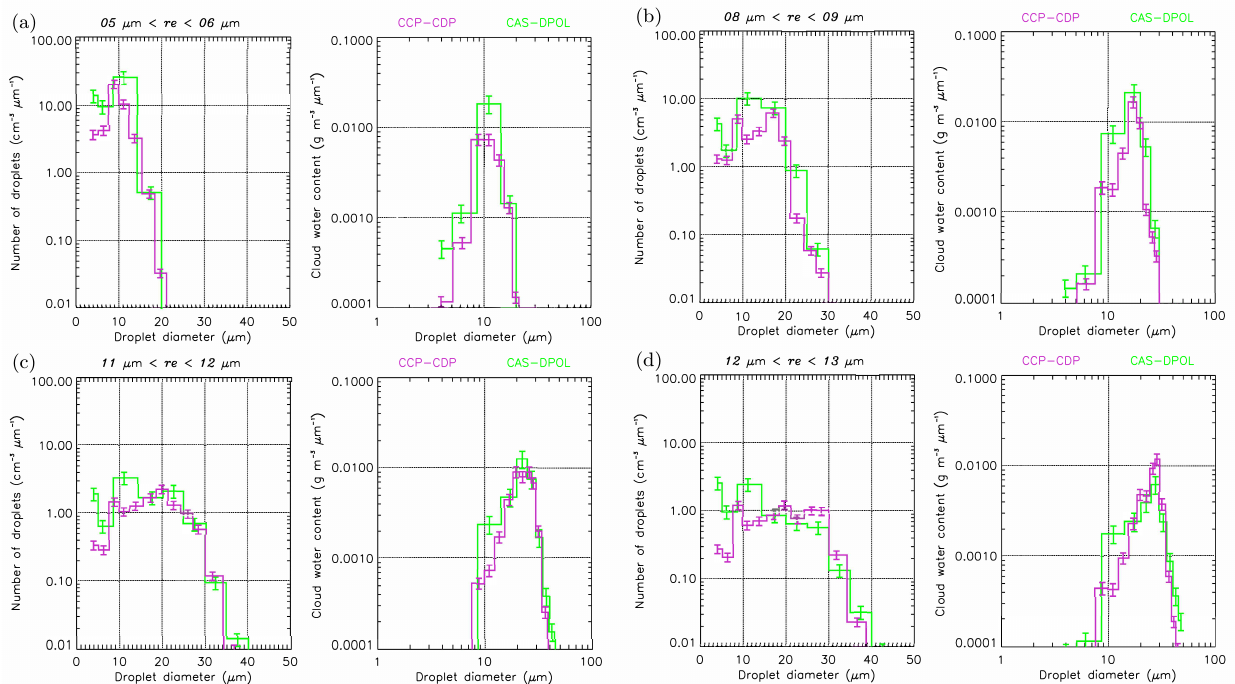
Figure 6. Mean cloud droplet concentration (solid lines) and cloud water content as a function of droplet diameter in the left and right panels, respectively, for (a) 5 µm <r e < 6µm, (b) 8µm <r e < 9µm, (c) 11µm <r e < 12µm, and (d) 12µm <r e < 13µm. The probes are identified by colors as shown at the top of the panels. The error bars indicate the uncertainty range of mean cloud droplet concentration and cloud water content values as a function of droplet